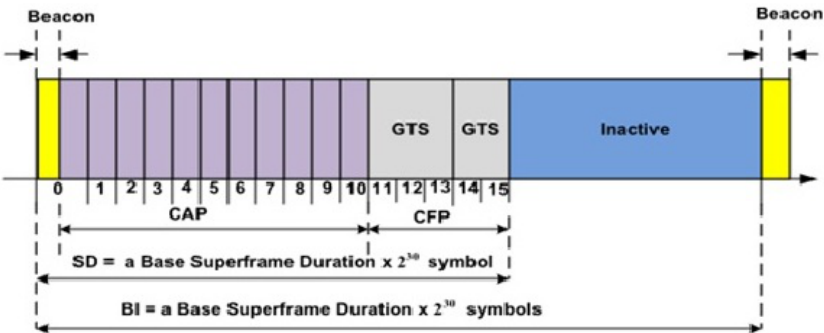
Figure 1. IEEE 802.15.4 superframe structure [1]. CAP: contention access period; CFP: contention-free period; GTS: gauranteed time slot; BI: beacon interval; SD: superframe